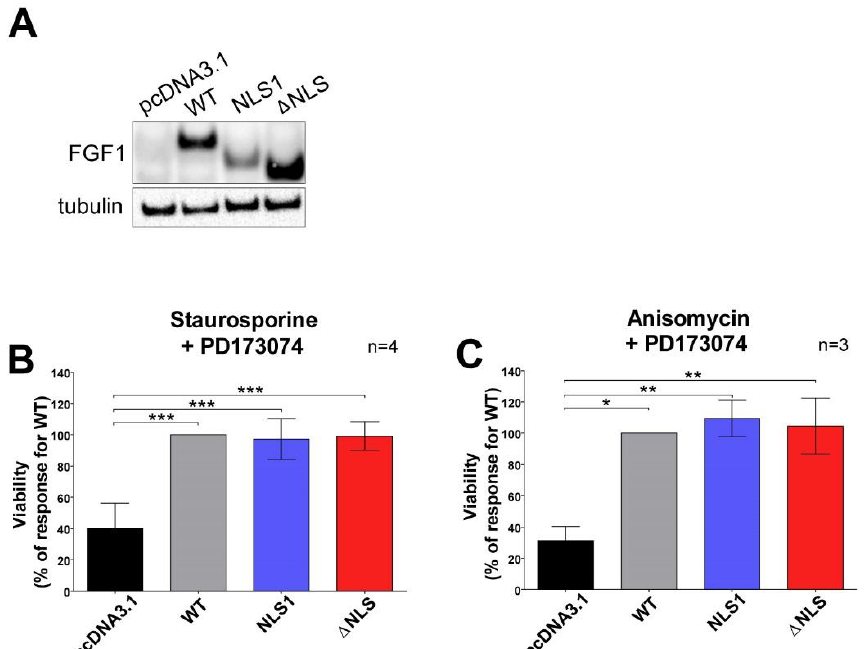
Figure 4. Endogenously expressed FGF1 inhibits apoptosis independently of its nuclear localization. U2OS cells were transiently transected with empty pcDNA3.1 vector or vectors encoding wild type of FGF1 (WT) and its mutated variants (NLS1 and ΔNLS). ( A ) The presence of an endogenous FGF1 pool was assessed after 48 h by Western blotting. To induce apoptosis 48 h after transfection, cells were subjected for 24 h to various apoptosis-inducing stimuli: ( B ) staurosporine (1 µM), and ( C ) anisomycin (10 µM) in the presence of the FGFR inhibitor, 100 nM PD173074. Then, the viability of cells was determined using Presto Blue reagent. Data were normalized to control values and presented as means ± SD of three or four independent experiments. Statistical significance: * p ≤ 0.05, ** p ≤ 0.01, *** p ≤ 0.001.